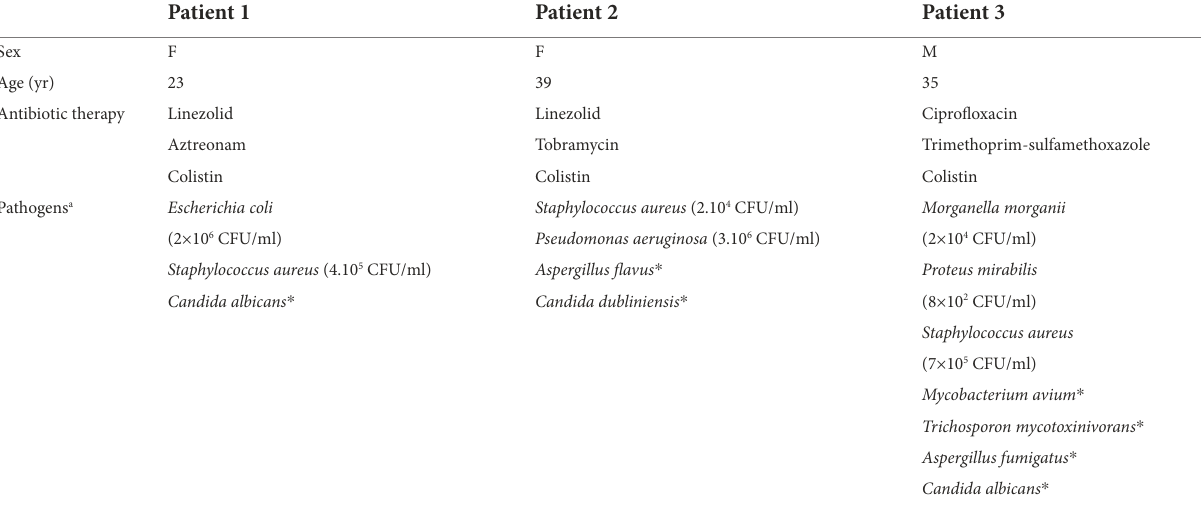
TABLE 2 Patient characteristics and results of spontaneous sputum sample